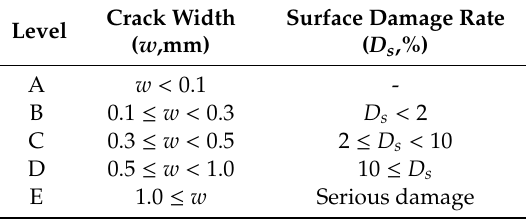
Figure 2. Condition level curves based on the standard performance degradation model. Table 4. Condition level evaluation criteria of the reinforced concrete (RC) slab [17].